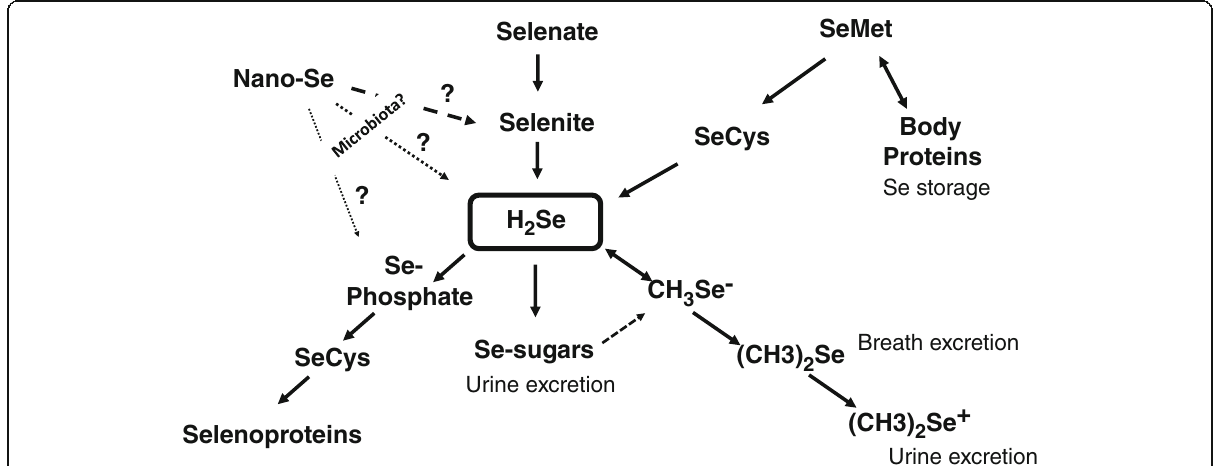
Fig. 1 Schematic model showing metabolic conversions of various forms of Se in animals. It is suggested that gut microbiota could convert nano-Se into selenite, H 2 Se or Se-phosphate with the following SeCys synthesis and incorporation into